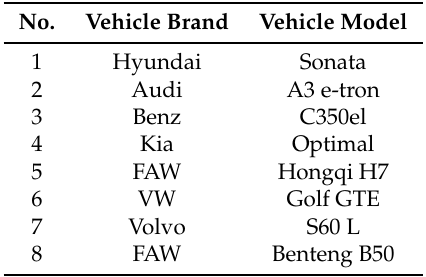
Table 3. The basic information of the 8 PHEVs.